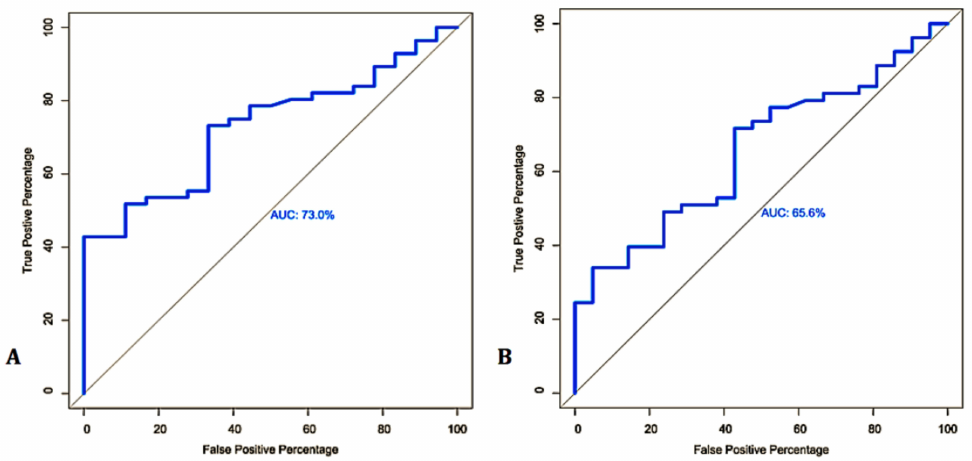
Figure 5. Receiver operating characteristic (ROC) curve analysis and corresponding area under the curve (AUC) analysis of the MELISA dataset when MqPCR and MELISA ( A ) and MqPCR ( B ) were considered as the reference models.